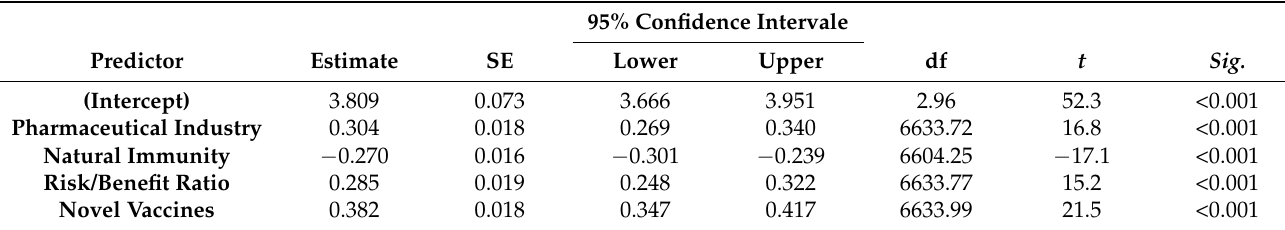
Table 6. Fixed effects parameters estimates of the predictors of willingness to receive COVID-19 vaccines, February 2021 ( n =